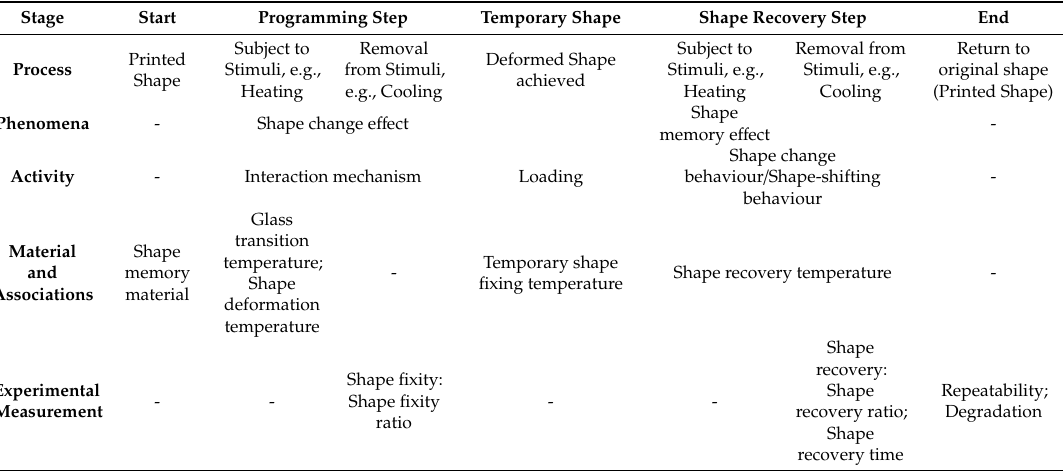
Table 1. Summary of the concepts and terminologies for 4D